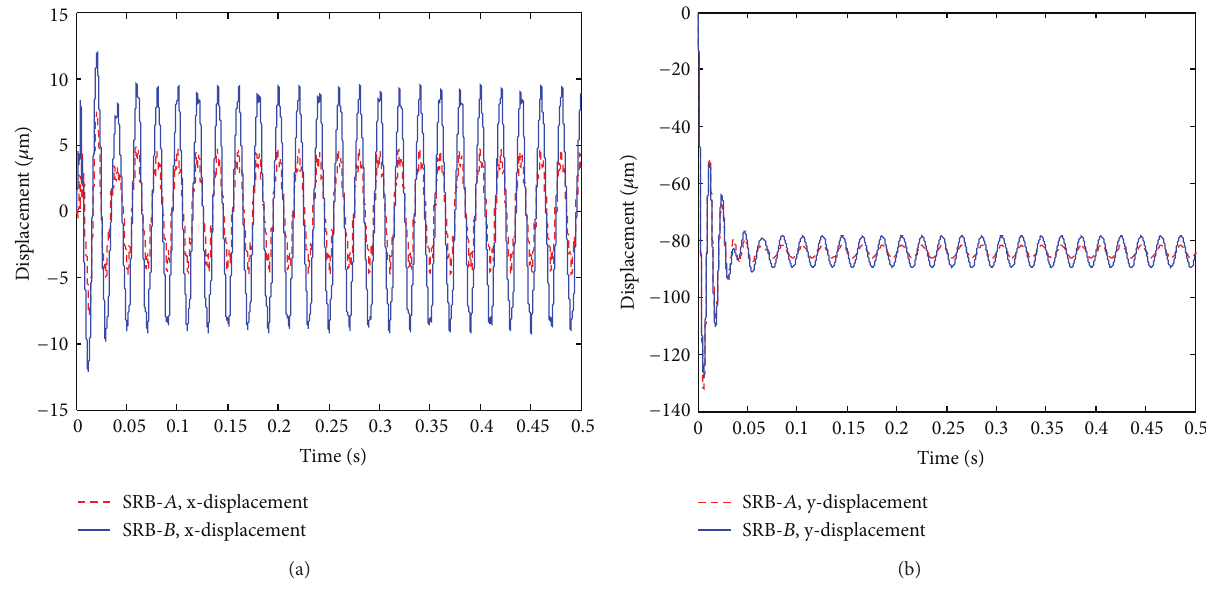
Figure 13: Simulated horizontal and vertical displacements of the rotor.